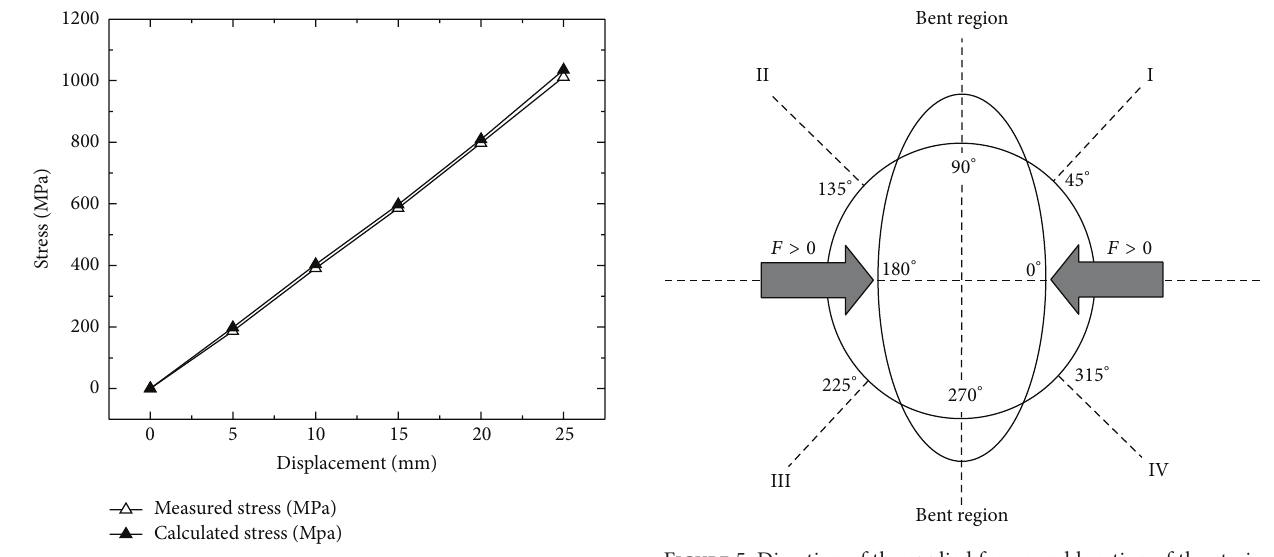
Figure 4: Comparison of the measured stress with calculated stress on the outer surface of the toroidal transducer core.